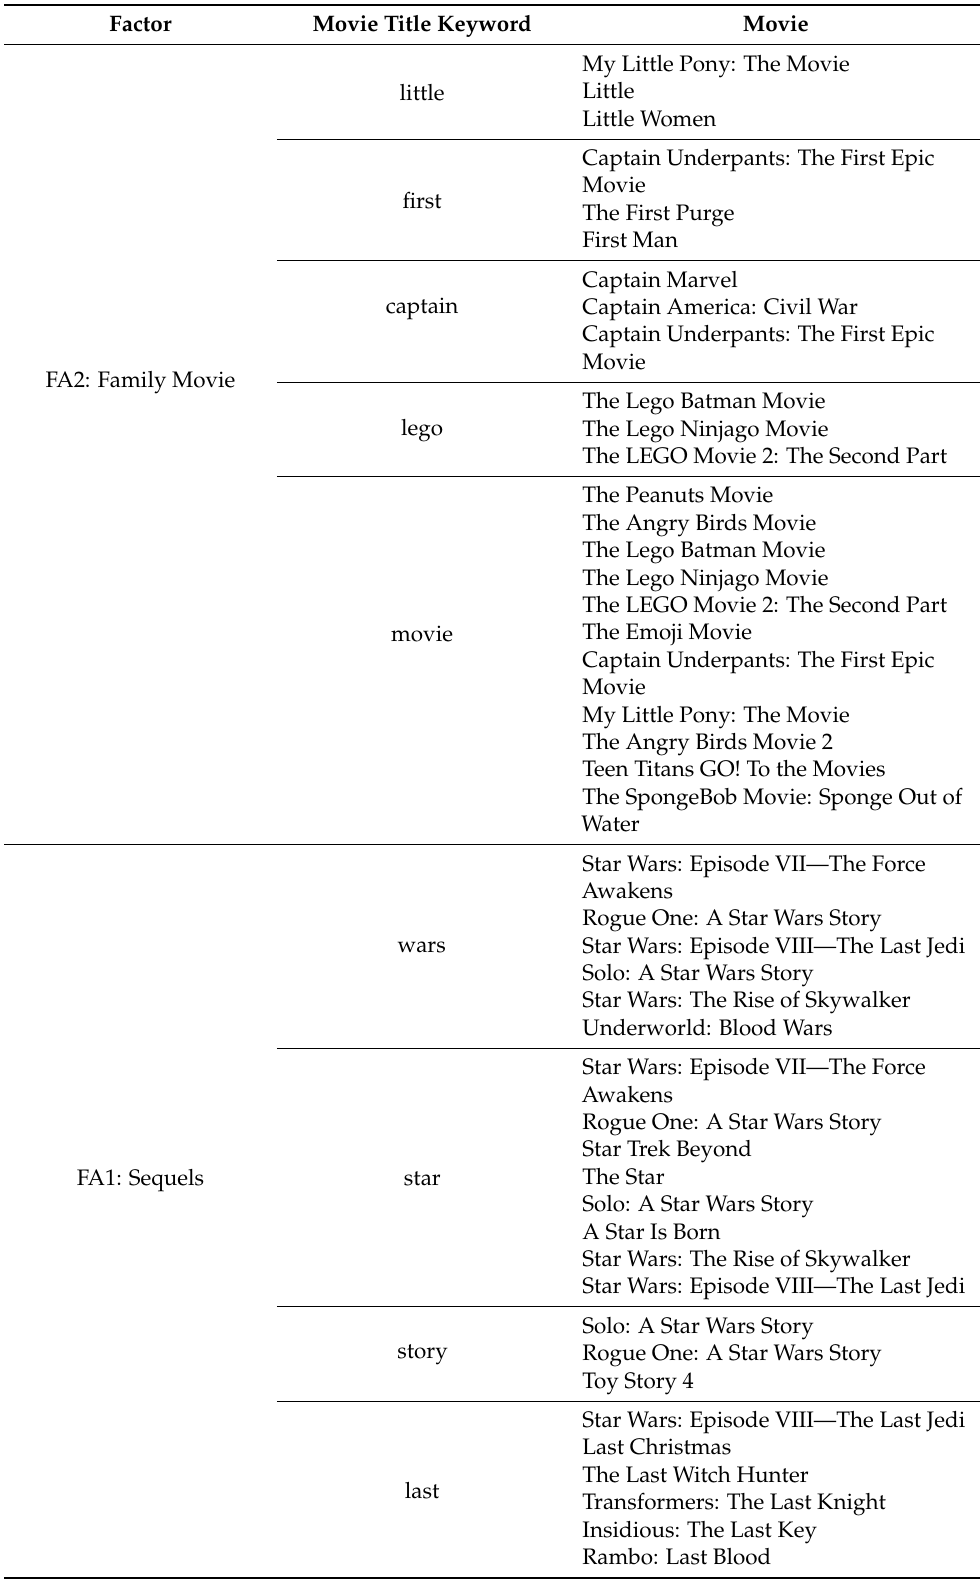
Table 5. Structure of the movie title keywords resulting from factor analysis in the U.S.